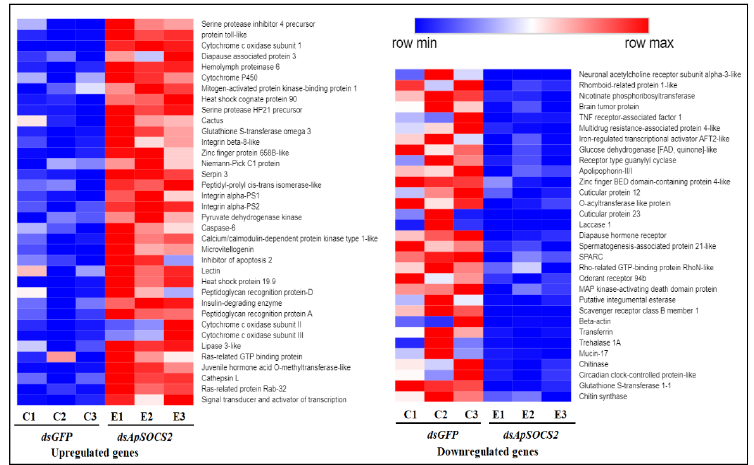
Figure 11. Cluster analysis of differentially expressed genes in the transcriptome following ApSOCS- 2 suppression and bacterial challenge in A. pernyi . Logarithmic fold alteration of dsApSOCS-2 + M. luteus versus dsGFP + M. luteus is presented in the heat map. C1, C2, C3 represent the control group, and E1, E2, E3 indicate the experimental group, each with three replicates. Row min.: row minimum, and row max.: row maximum.